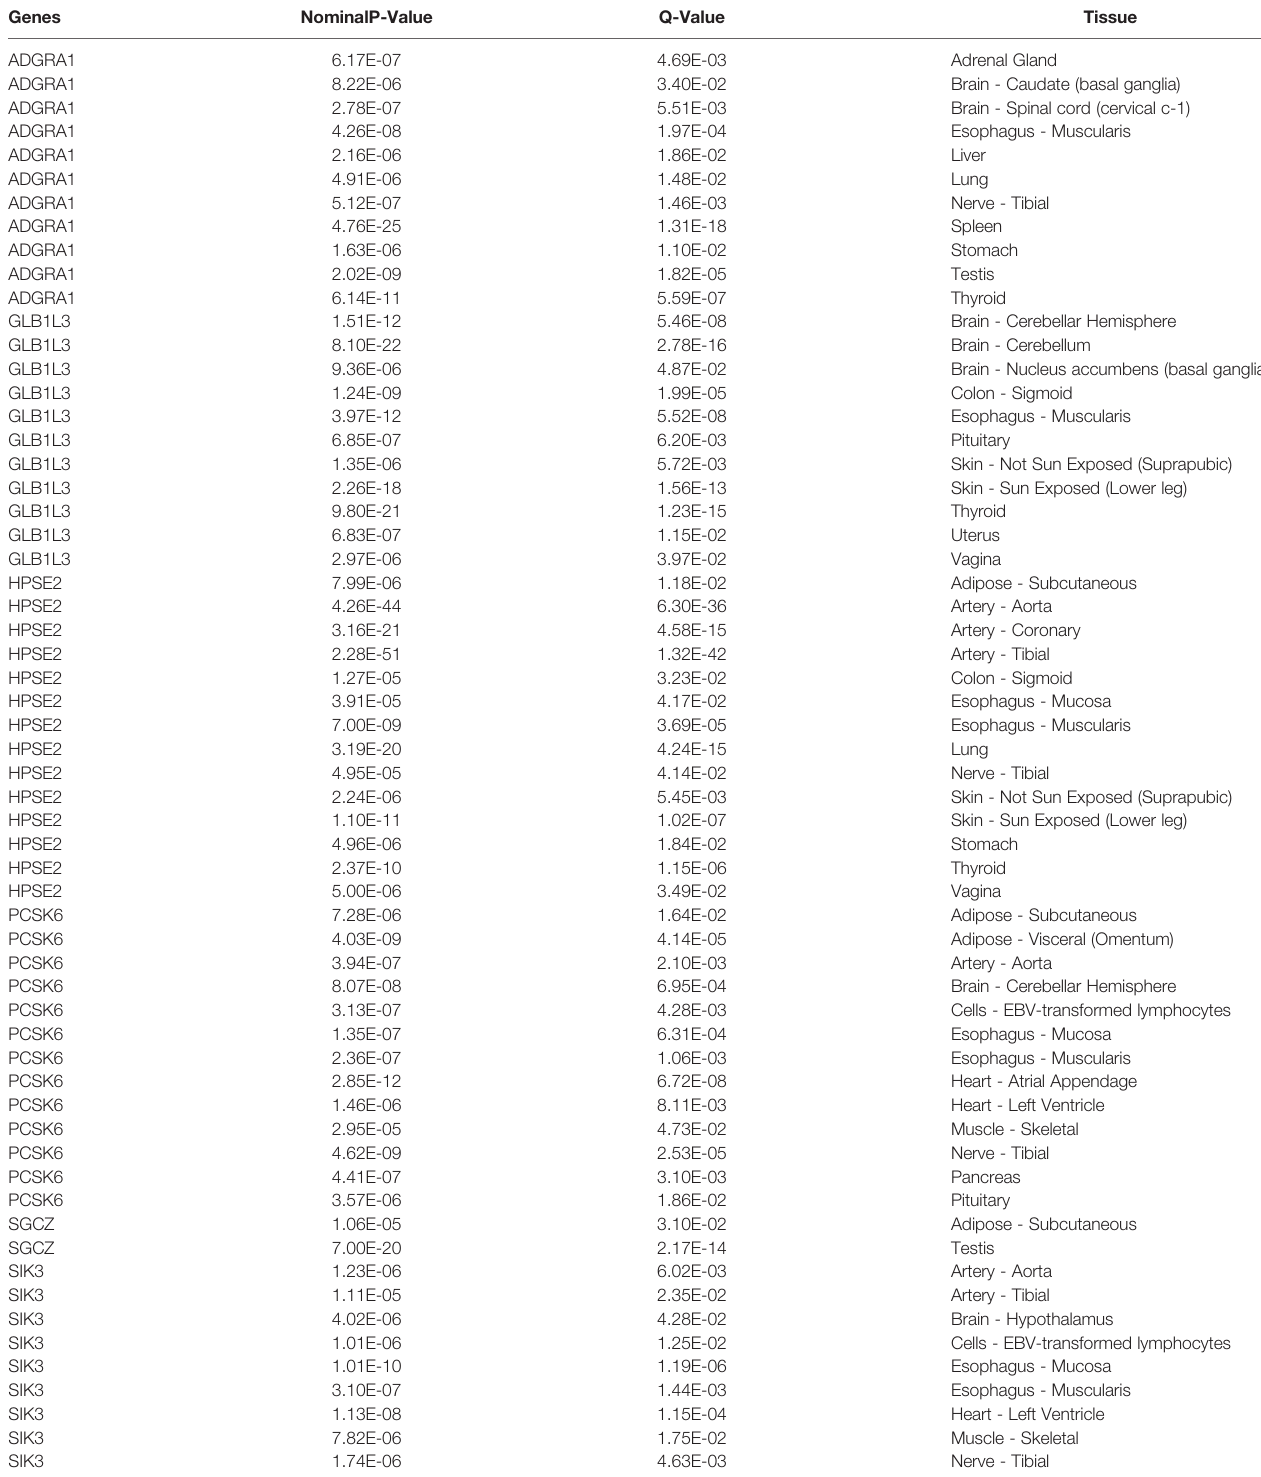
TABLE 4 | Tissues with eGenes for signi fi cant genes identi fi ed in genome-wide gene-based analyses. Genes NominalP-Value Q-Value Tissue